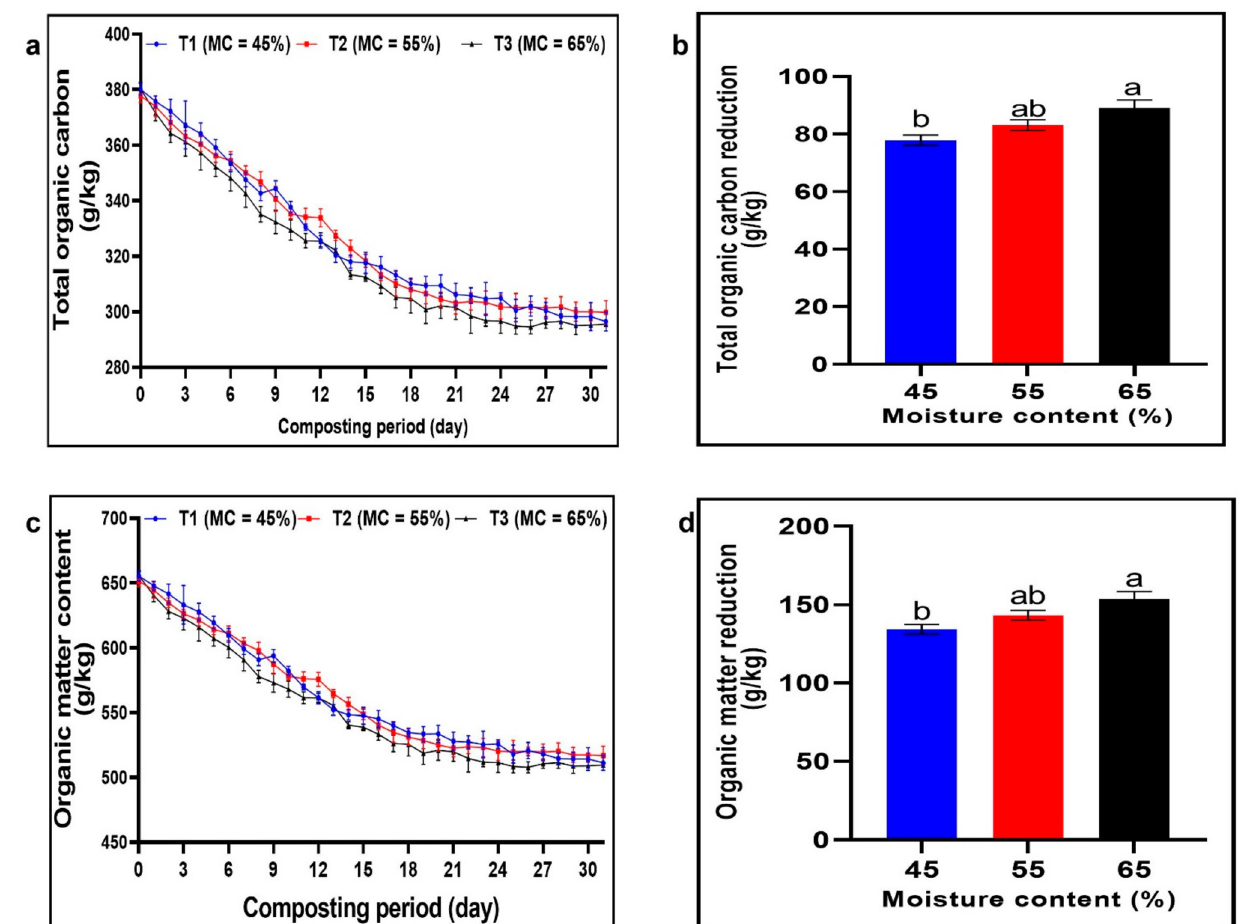
Figure 3. Temporal evolution of total organic carbon ( a , b ) and organic matter ( c , d ) content during composting under different moisture